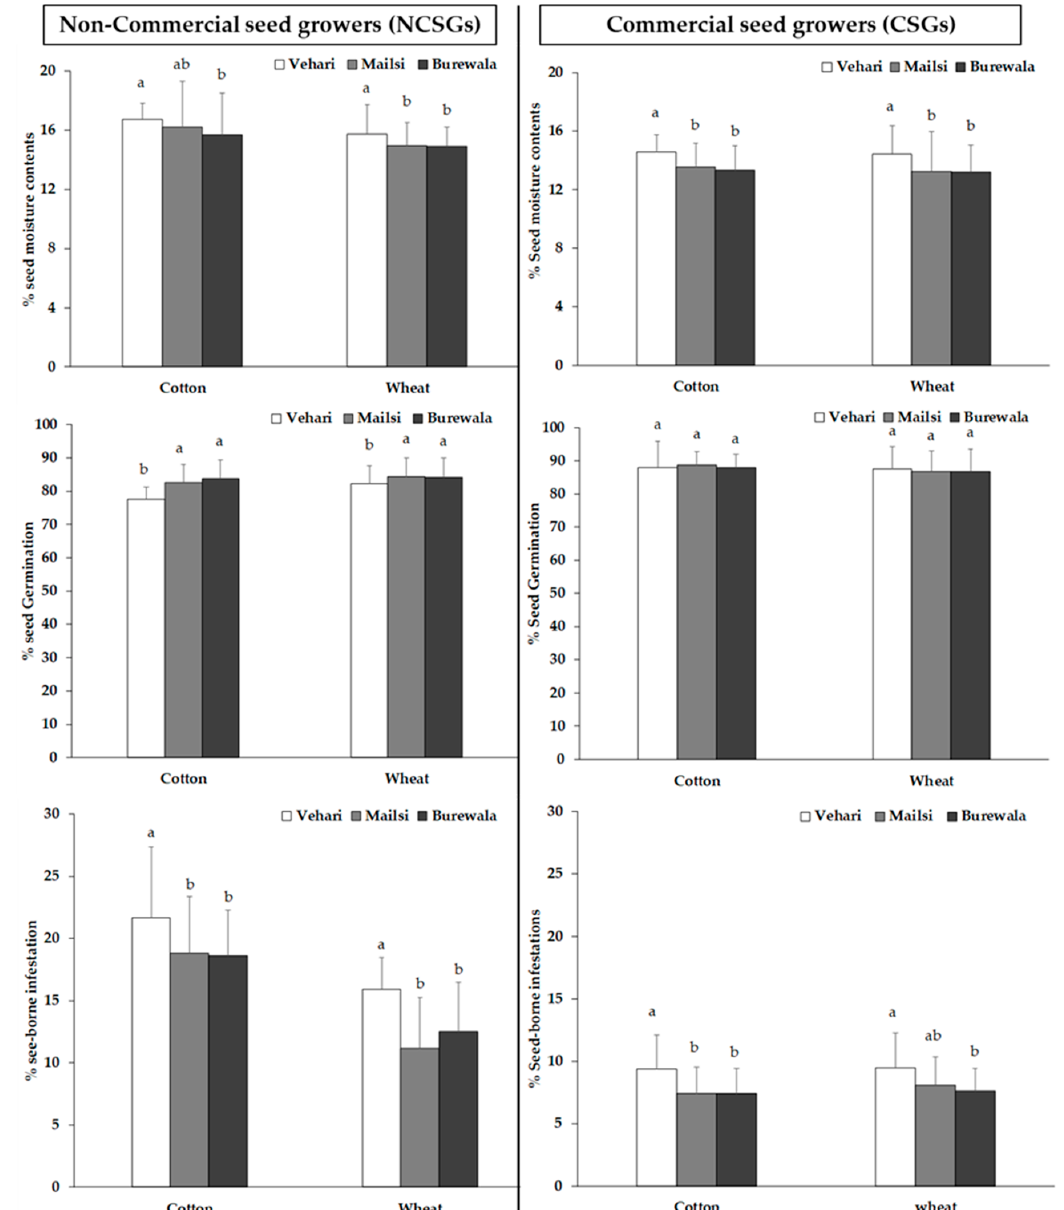
Figure 1. Percentages of seed moisture contents, seed germination and seed-borne infestations of cotton and wheat seeds from stored samples collected from non-commercial seeds growers (NCSGs) and commercial seeds growers (CSGs) in Vehari (Pakistan). Data presented in the graphs are means with standard deviation, bars sharing same letter(s) within each parameter are statistically non-significant according to HSD Tukey test at p < 0.05.